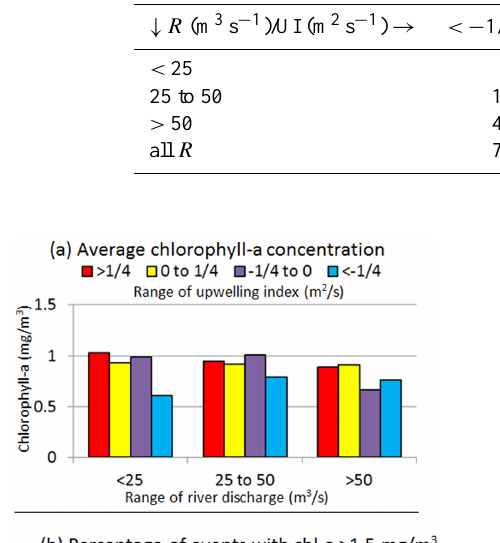
Table 1. Number of valid events of the time series (1 January 2005 to 31 March 2014) grouped according to different intervals of upwelling index (UI) and river discharge ( R ).